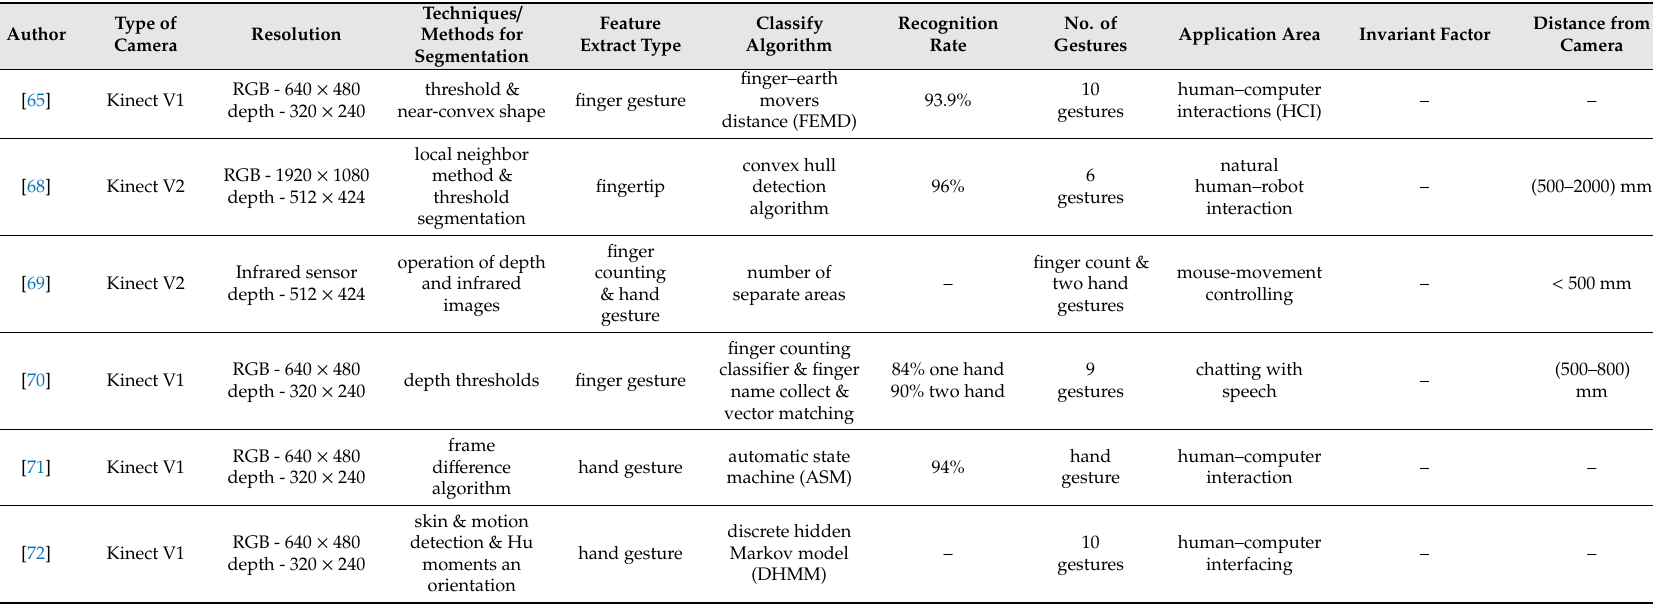
Figure 10. Depth-based recognition: ( a ) hand joint distance from camera; ( b ) different feature extraction using Kinect depth sensor. Table 5. Set of research papers that have used depth-based detection for hand gesture and finger counting application.